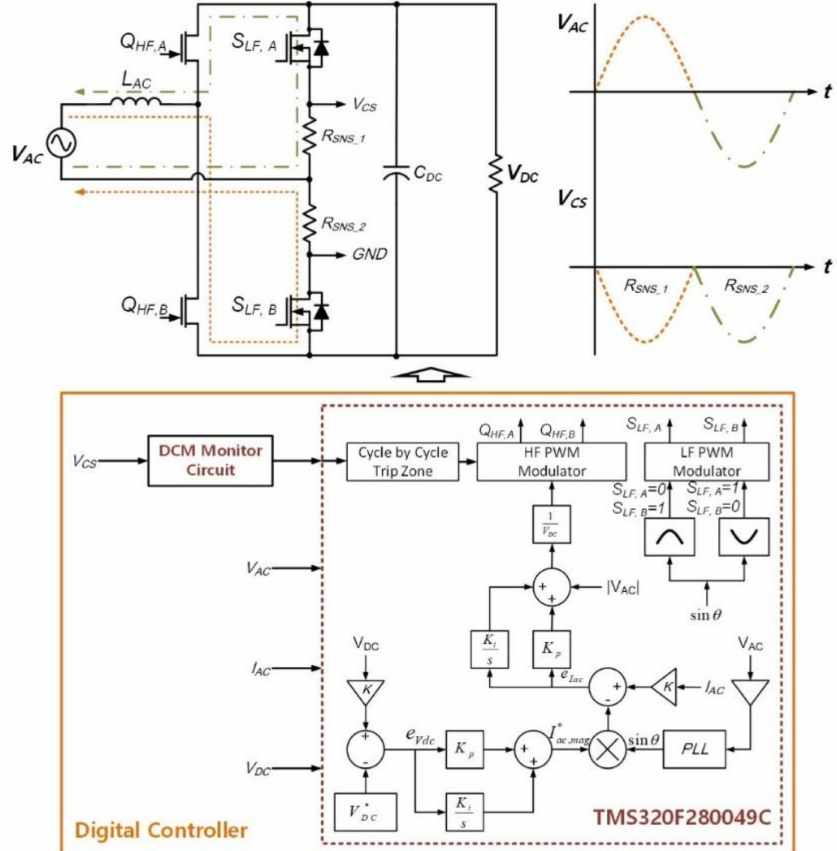
Figure 5. Control block diagram of totem-pole PFC using digital signal processor